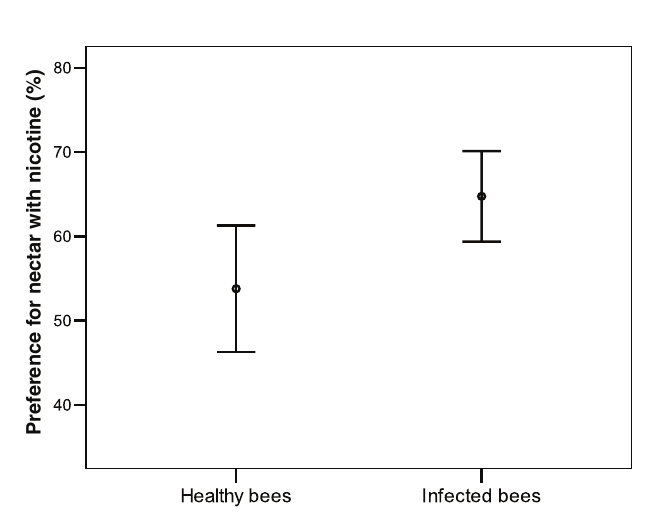
Figure 4. Percentage of preferred flowers rewording with nicotine- rich artificial nectar by infected bees ( n = 31) and healthy bees ( n = 28), (t test, P = 0.016). Infected bees visited nicotine-containing flowers 64.5 ± 13.8 (s.d.) times while healthy bees visited